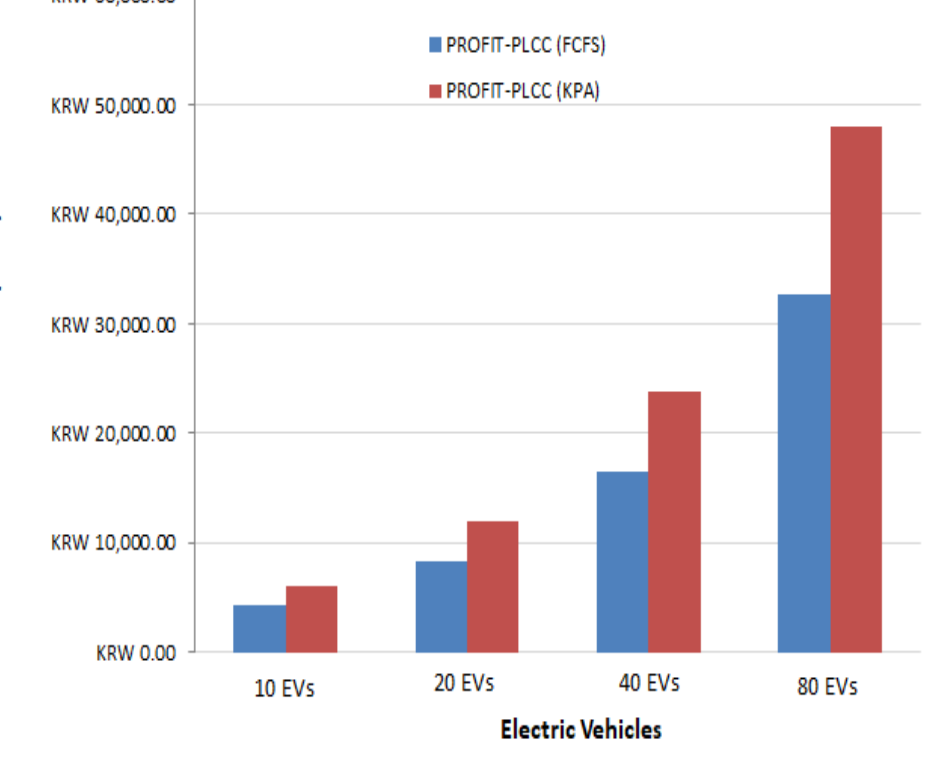
Figure 11. Average parking lot profits for different numbers of buying vehicles.